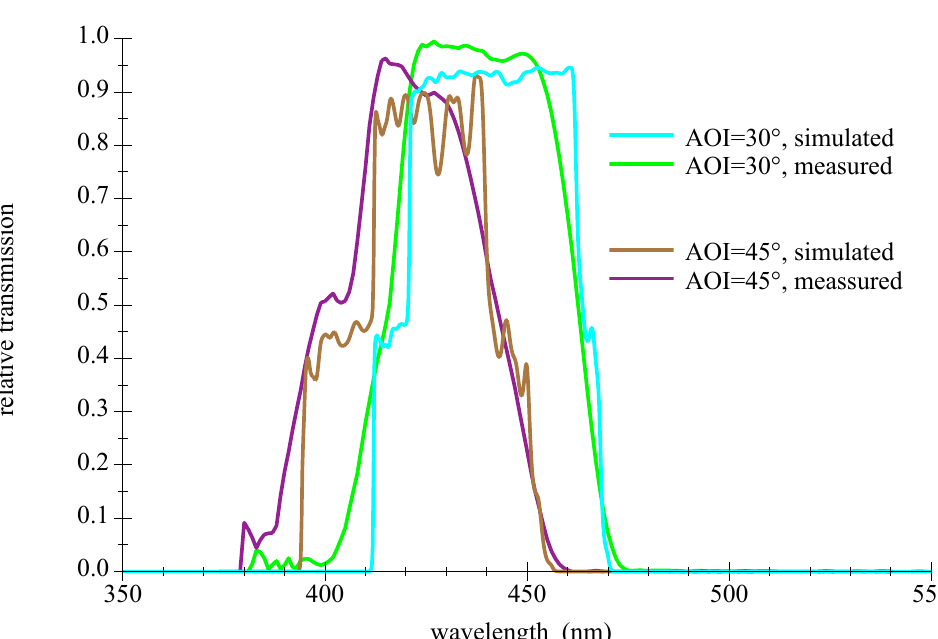
Figure 14. Comparison of measured and simulated spectral transmission curves for a thin film bandpass filter Semrock 457-50 for large AOI. For further information please refer to the appendix